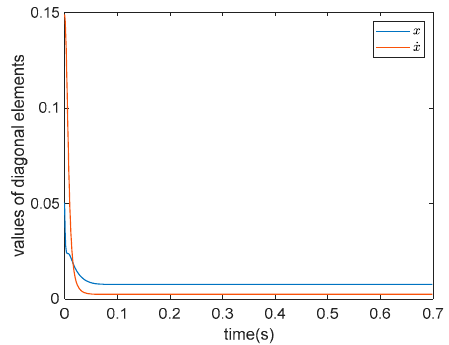
over time for example 2. Figure 12. The values of diagonal elements of covariance matrix P i k k